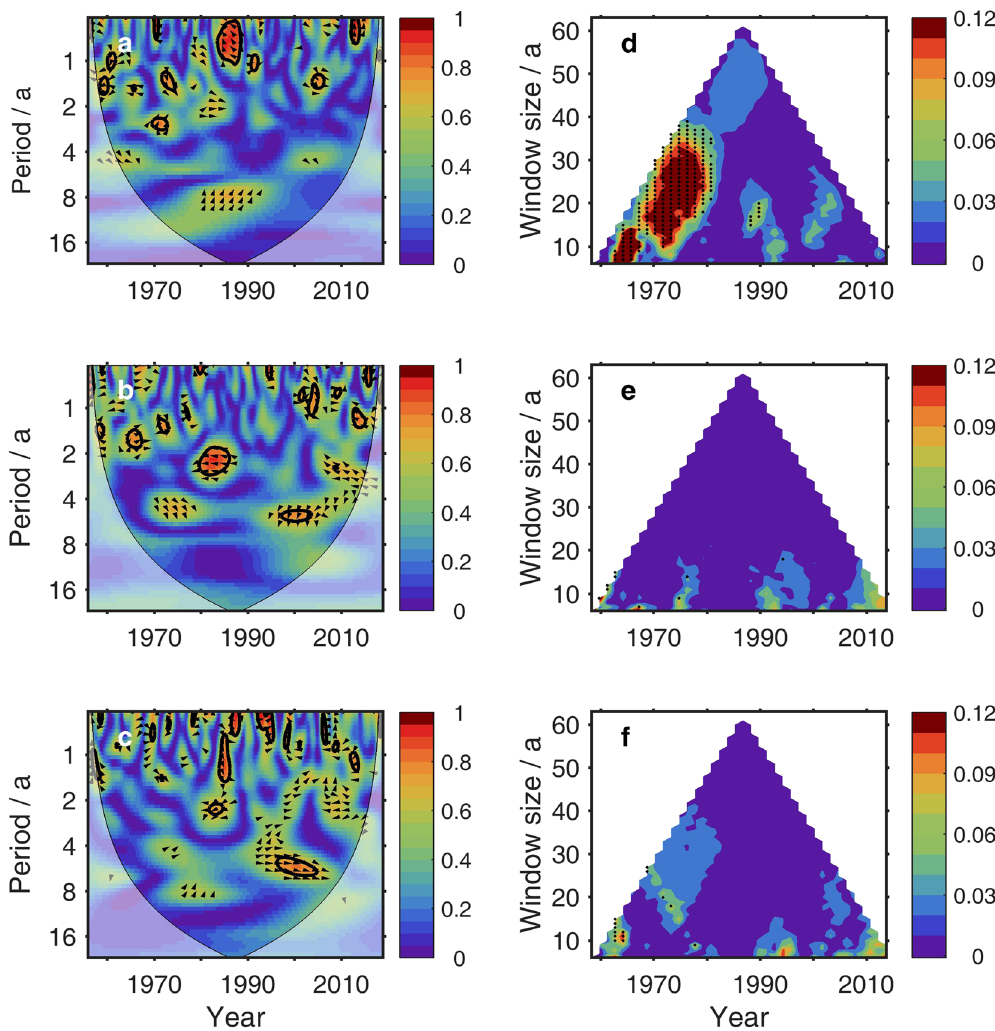
Figure 6. The original incorrect version of Figure